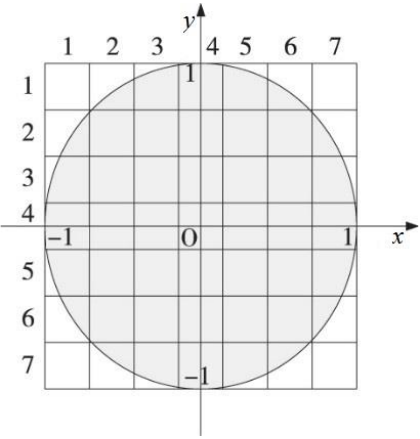
Figure 4. 7 × 7 Template.